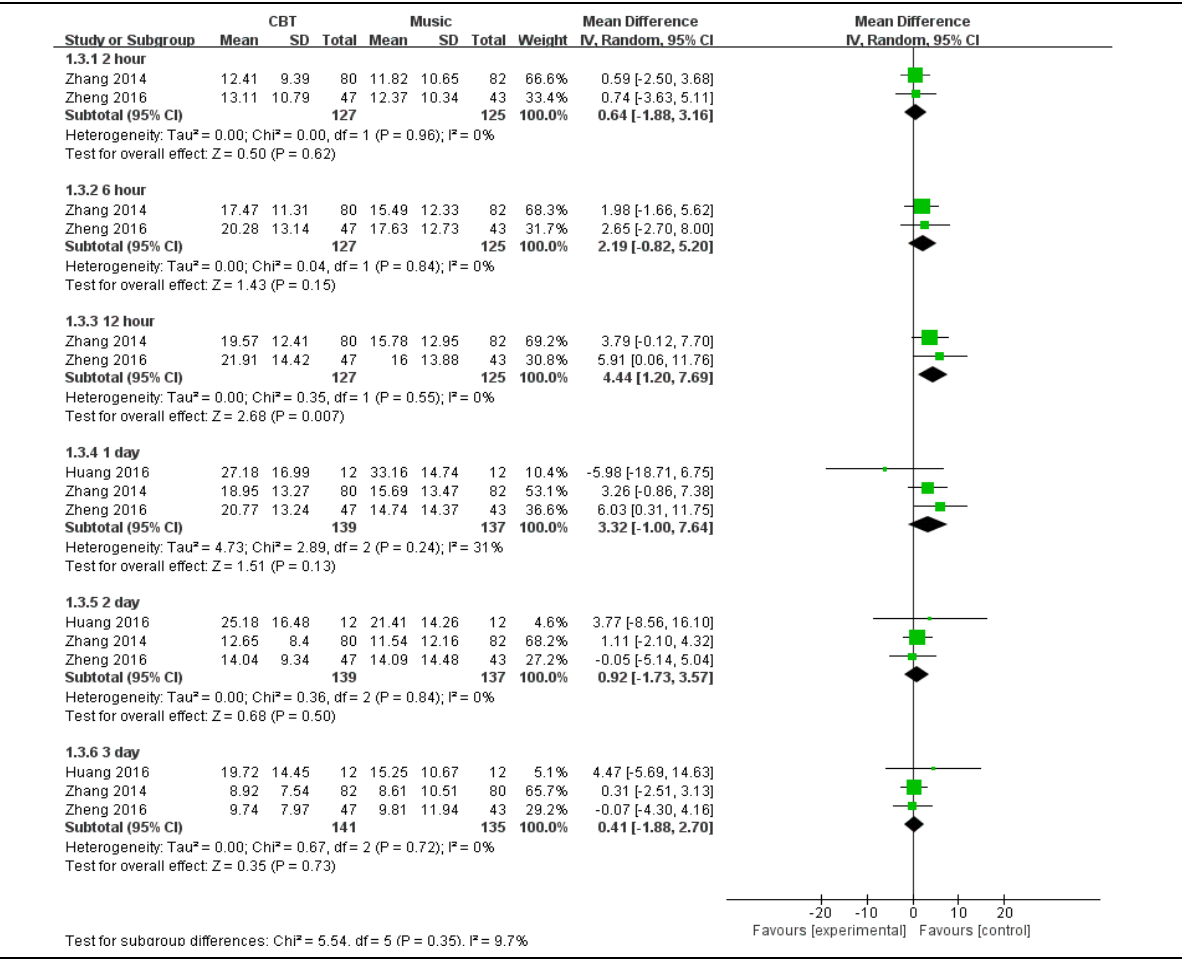
difference (95% confidence interval), show both interventions have similar effectiveness of pain